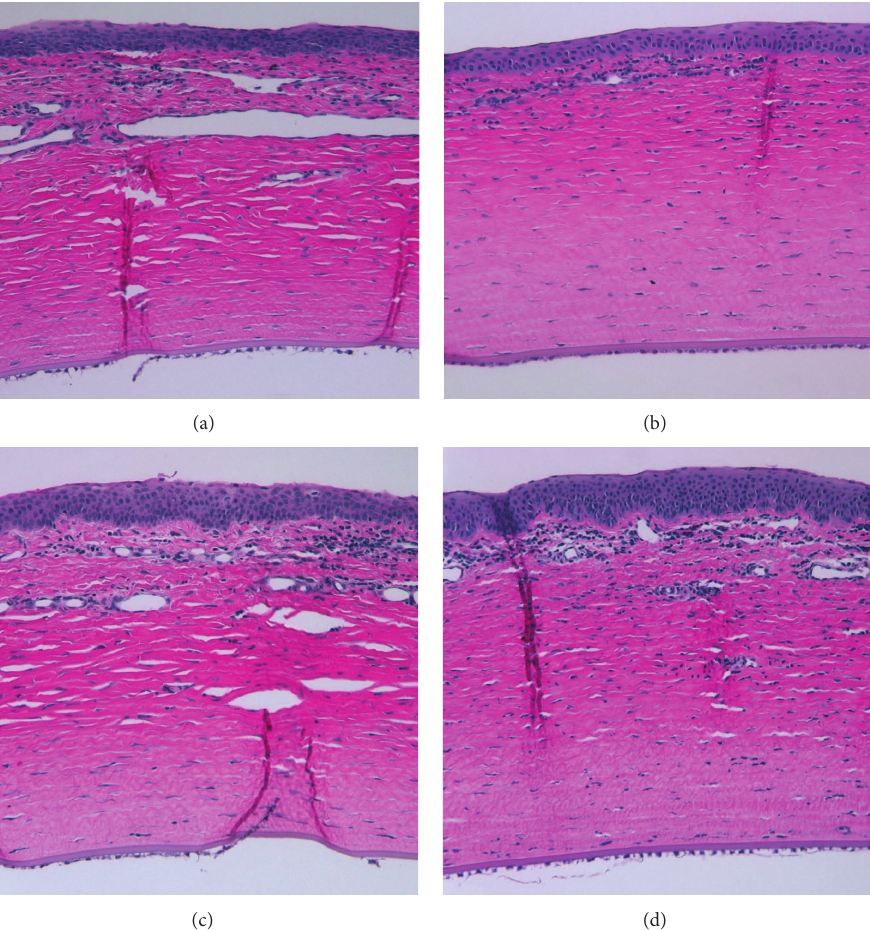
Figure 5: Corneal histology. On day 15, all eyes were enucleated and fixed in formalin. After fixation in formalin, corneas were removed, embedded in paraffin, and stained with hematoxylin and eosin (H&E). Pictured are H&E stained slices taken at the cornea-sclera border. The cornea epithelial surface is facing up. (a) Normal saline (group); (b) bevacizumab 25mg/mL; (c) Fc-endostatin 2 mg/mL; and (d) Fc- endostatin 20